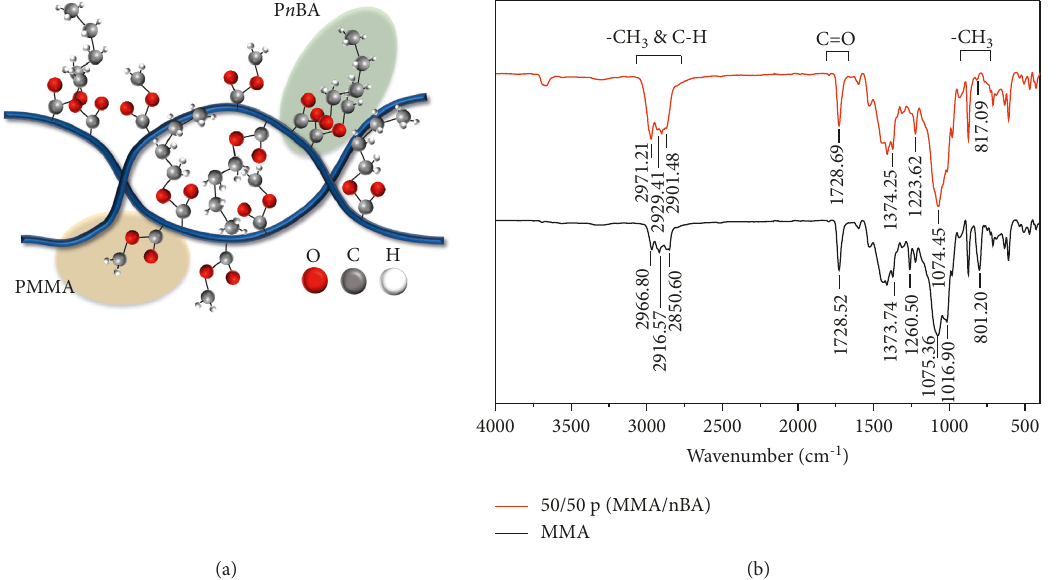
Figure 7: Molecular configuration of poly(MMA-r-nBA) coatings and proposed toughness mechanism. (a) Chemical structure of the poly(MMA-r-nBA) copolymer; the hard monomer (pMMA) and soft monomer (pnBA) units are indicated by yellow and green color, respectively. (b) ATR-FTIR spectra shows the comparison intensities of chemical groups in the MMA(black) and 50/50 poly(MMA-r-nBA) (red),